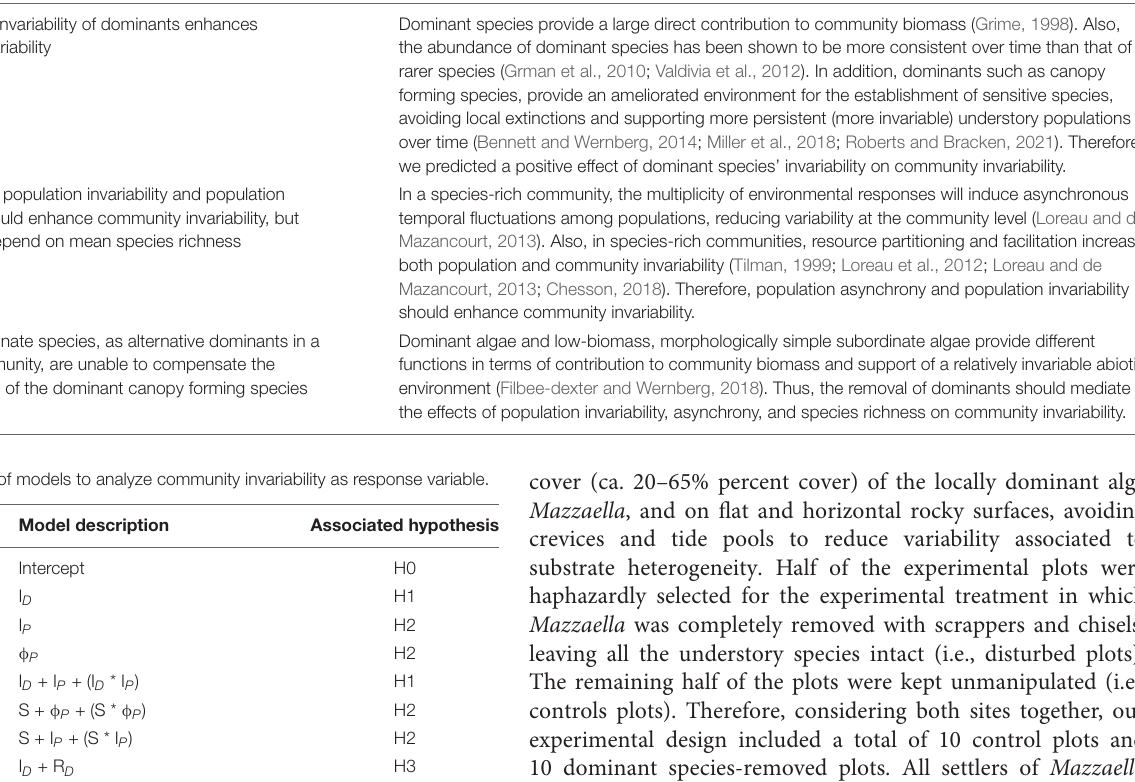
TABLE 1 | Empirical support of hypotheses proposed to explain invariability in our experimental community. Hypothesis Explanation